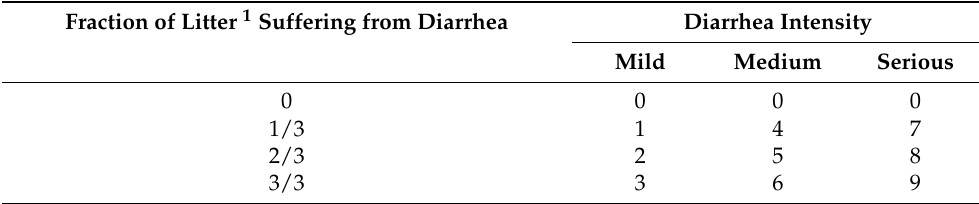
Table 4. Scores for diarrhea incidence assigned to each cage/pen on the basis of the fraction of litter suffering from diarrhea and diarrhea intensity. Fraction of Litter 1 Suffering from Diarrhea Diarrhea Intensity Mild Medium